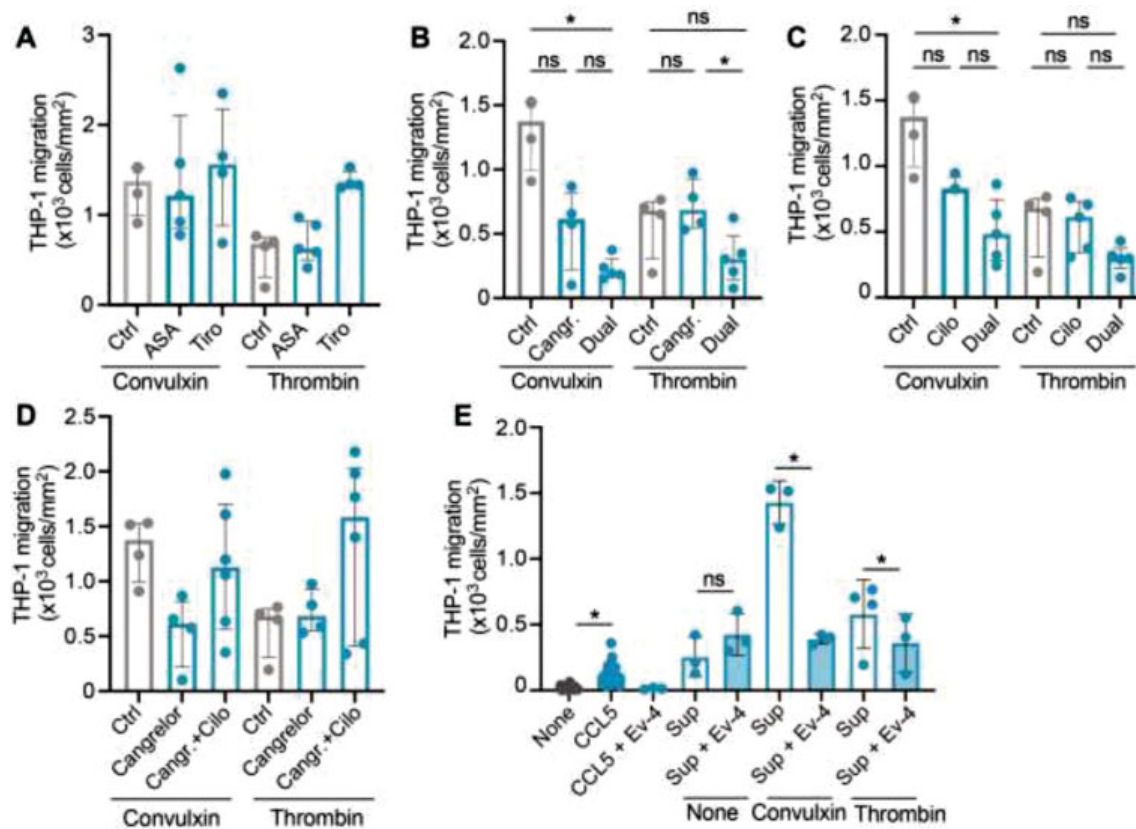
Fig. 7 Chemoattractant properties of activated platelets and the effects of antiplatelet drugs. Migration of monocytic cells (10 6 /mL) was induced in a 12-well chemotaxis chamber for 90minutes at 37°C. Buffer, or supernatants of resting or activated washed platelets, was added in the bottom compartment. If applicable, platelets were activated by convulxin or thrombin without or with acetylsalicylic acid (ASA) or tiro fi ban ( A ), cangrelor or ASA þ cangrelor (dual) ( B ), cilostazol (cilo) or ASA þ cilo (dual) ( C ) , and cangrelor or cangrelor þ cilo ( D ). CCL5 (0.5 µg/mL) and platelet releasates without or with Evasin-4 (Ev-4, 1 µg/mL) ( E ). n ¼ 4 – 6; median with interquartile range. (cid:4) p < 0.05; Kruskal – Wallis with Dunn ’ s